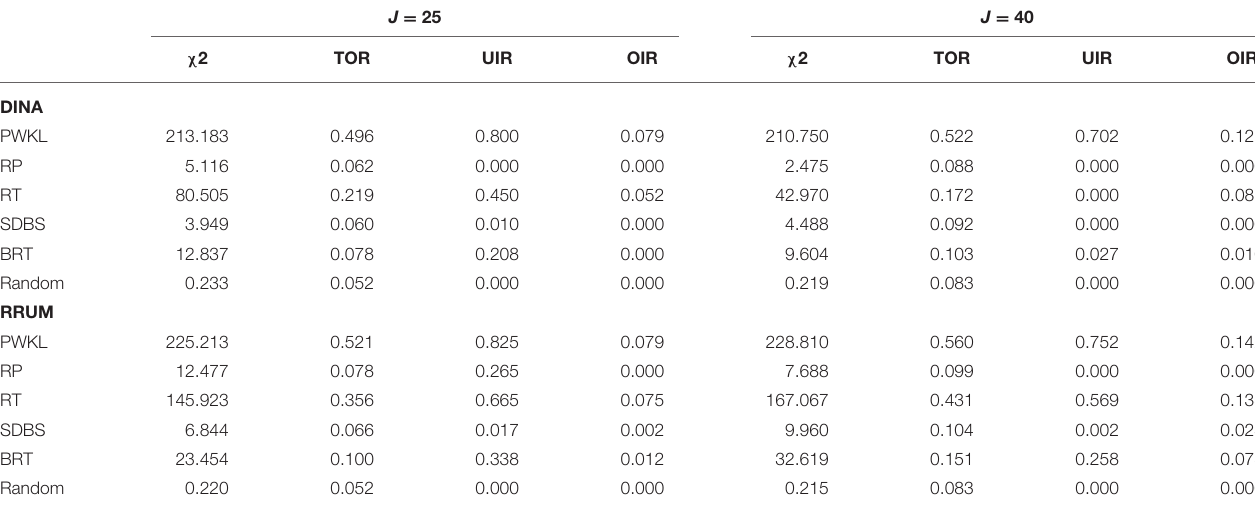
TABLE 3 | The usage of items for four attributes.